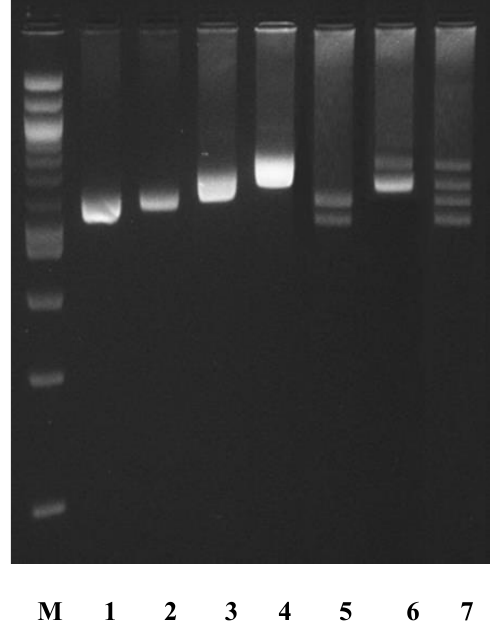
Figure 2. Electrophoretic pattern of amplification products by polymerase chain pattern of amplification products by PCR of DNA region including the 5 ’ -end of the gene Figure 2. Electrophoretic reaction of DNA region including the 5’-end of the gene coding for bovine coding for bovine (pattern 1), buffalo (pattern 2), goats (pattern 3), and sheep (pattern 4) α -lactalbumin ( LALBA ). (pattern 1), buffalo (pattern 2), goats (pattern 3), and sheep (pattern 4) α -lactalbumin (LALBA). Pattern 5: DNA amplification products from buffalo and Pattern 5: DNA amplification products from buffalo and cattle. Pattern 6: DNA amplification products from sheep and cattle. Pattern 6: DNA amplification products from sheep and goats. Pattern 7: goats. Pattern 7: DNA amplification products from cattle, buffalo, goat and sheep. M: 2-log DNA ladder (0.1 – 10.0 kb) DNA amplification products from cattle, buffalo, goat and sheep. M: 2-log DNA ladder (0.1 to 10.0 kb) (New England Biolabs, Ipswich, MA, USA). (New England Biolabs, Ipswich, MA,